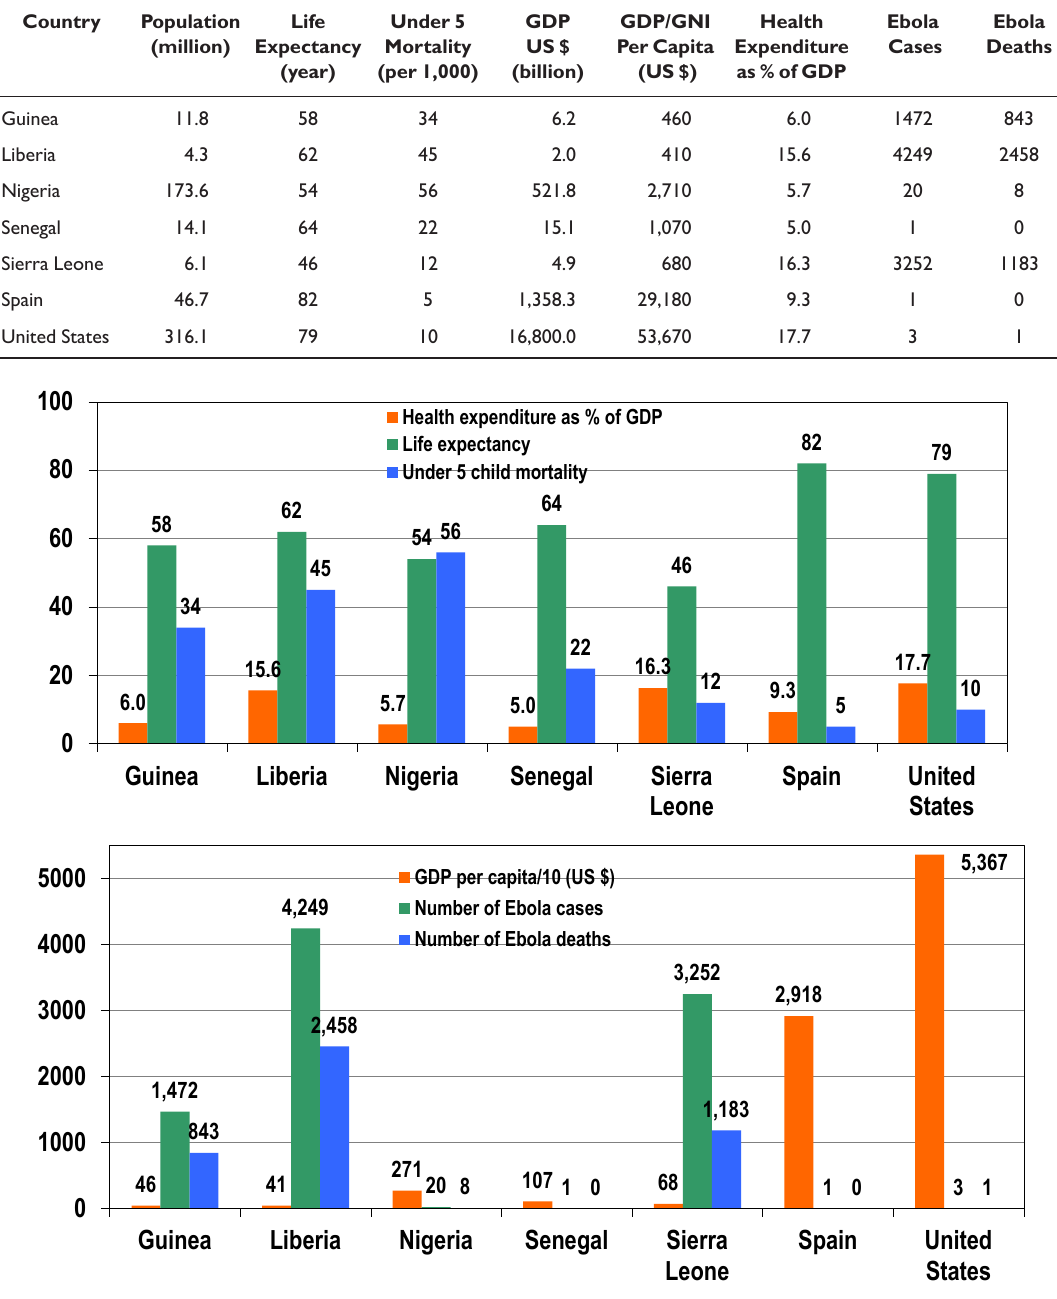
Figure 1. Health Expenditure, GDP, and Selected Health Indicators in Ebola Affected Countries Source: US Centers for Disease Control & Prevention (CDC), 2014; World Health Statistics, 2014; World Bank data, 2014 Note: Ebola statistics reported by CDC as at October 16,